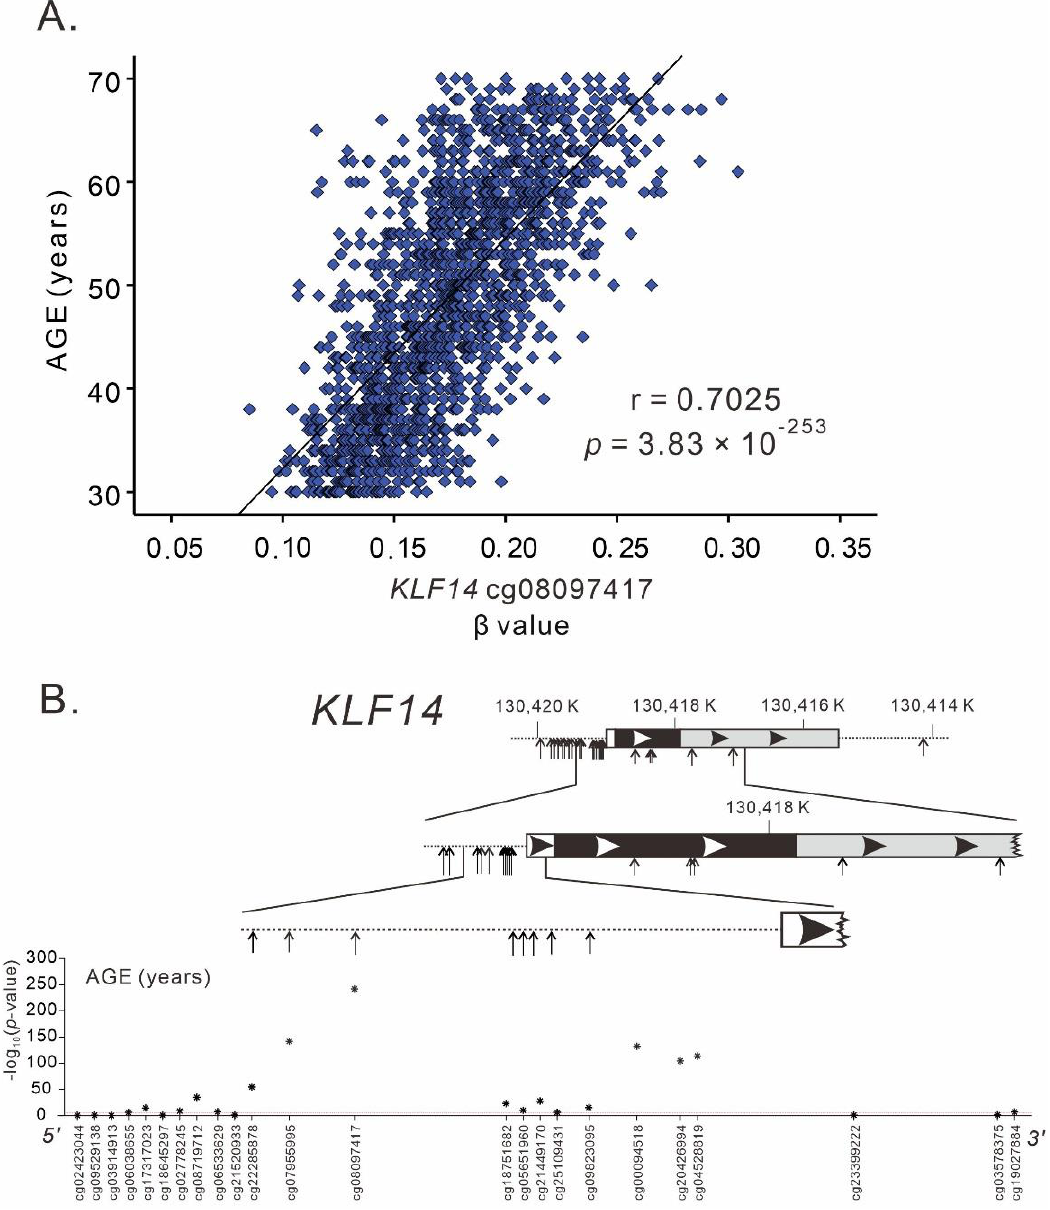
Figure 2. KLF14 methylation and age: ( A ) Association between KLF14 promoter methylation cg08097417 level and chronologic age and ( B ) Genomic structure of KLF14 and the association between KLF14 methylation status and age.